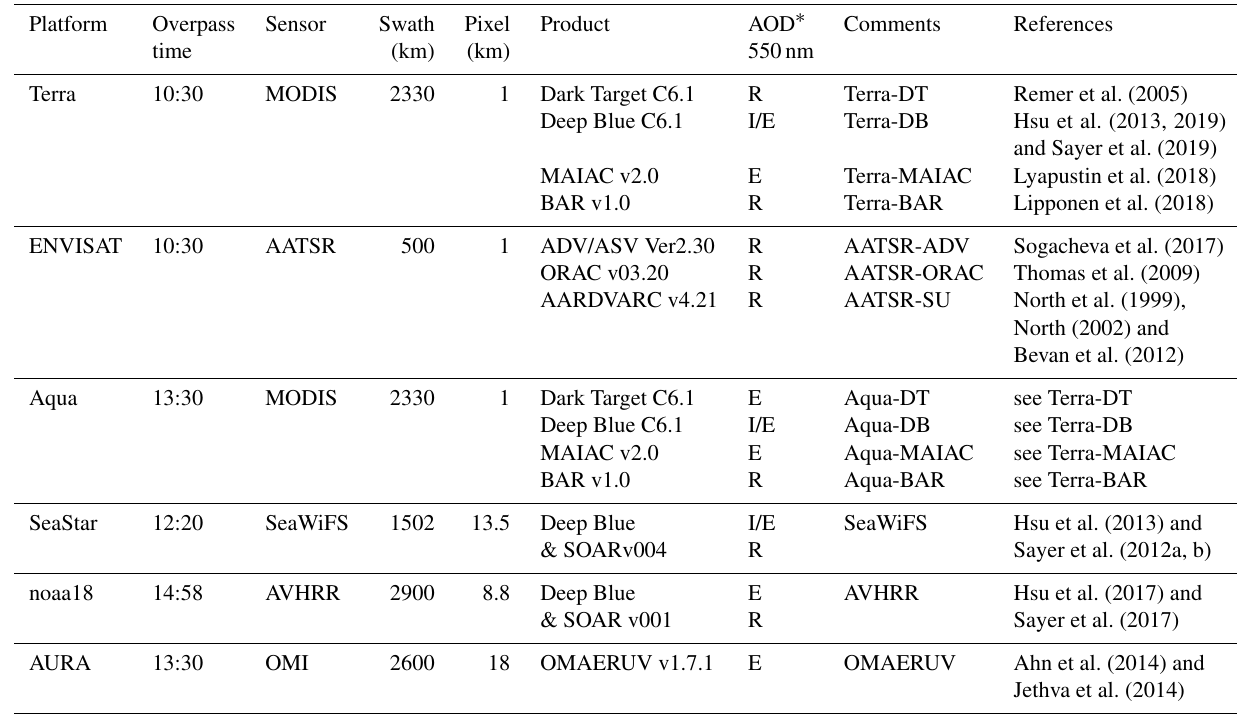
Table 2. Remote sensing products used in this study.